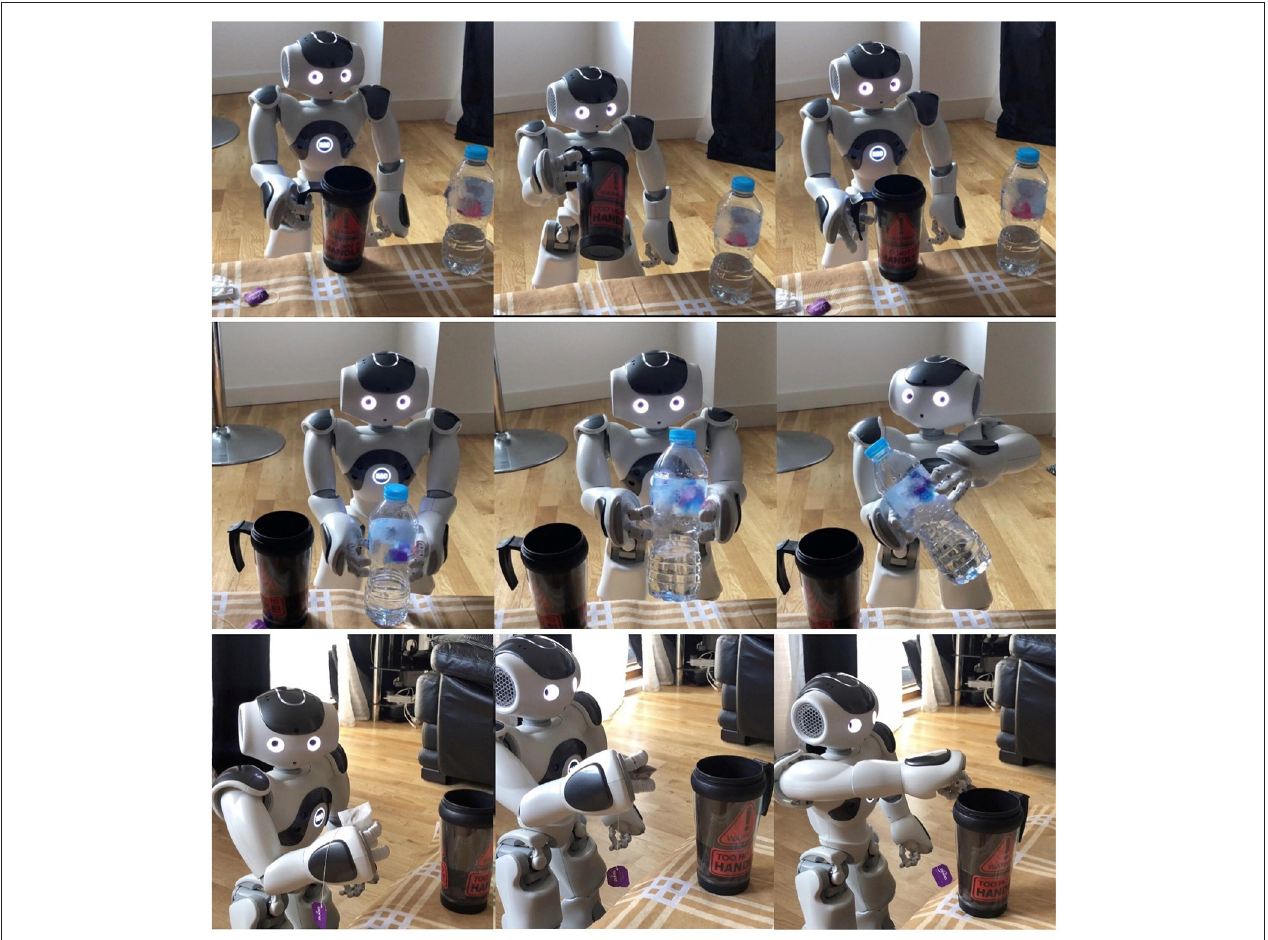
FIGURE 7 | Demonstration of the NAO robot performing the task “NAO make me a tea.”